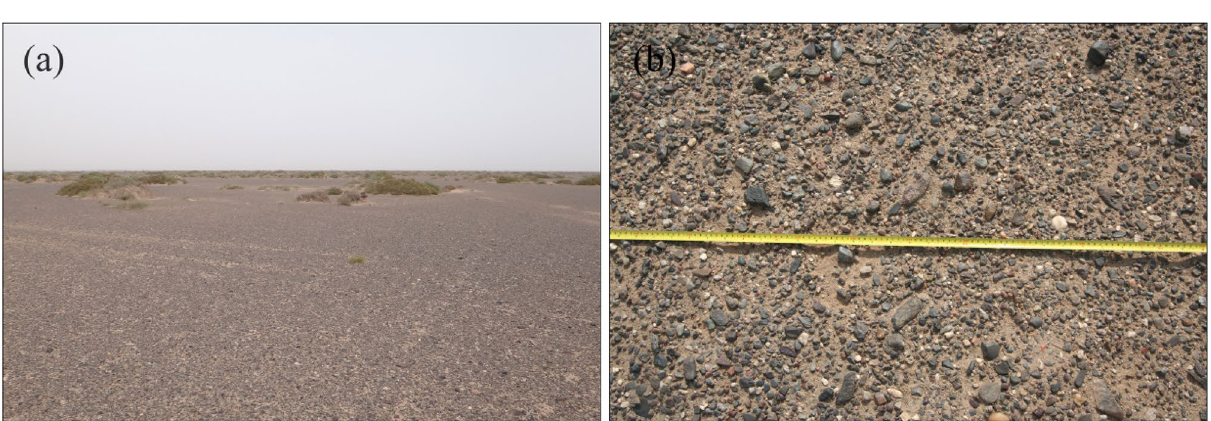
Figure 4. Original surface of gobi region in Ejina Qi, “Black vegetation” covers the surface of the land ( a ) and has grain sizes of 2–40 mm ( b